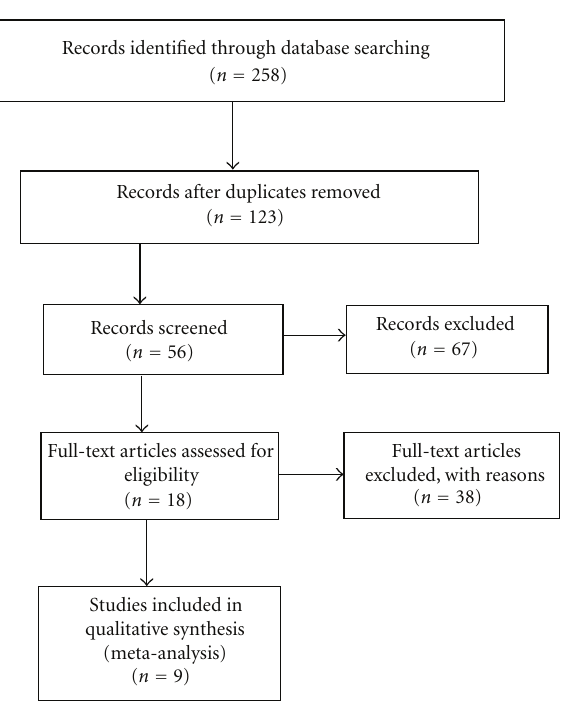
Figure 1: Selection of studies for inclusion in the meta-analysis.